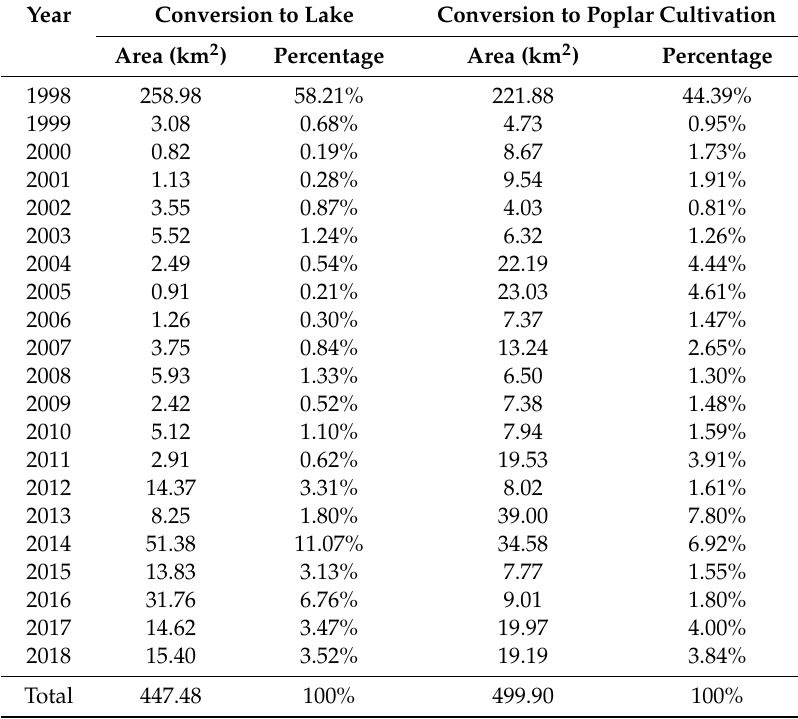
Figure 6. Year of conversion from cropland to lake with four areas shown in detail: (L1) Datong Lake; (L2) West Dongting Lake; (L3) South Dongting Lake; (L4) East Dongting Lake (scale of the four areas is 1:130,000). Table 2. Yearly change area for both conversions from 1998 to 2018 by area and the conversion area per year as a percentage of the total converted area for all years .